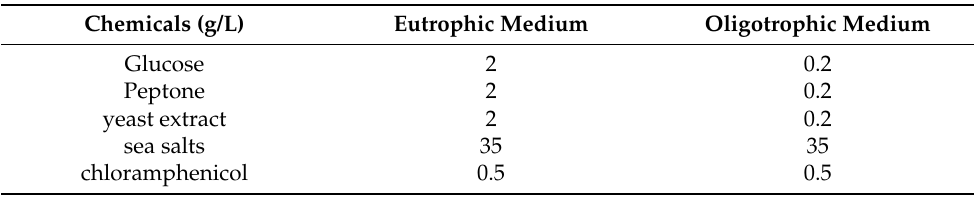
Table 2. Growth media used for marine yeast liquid cultures.